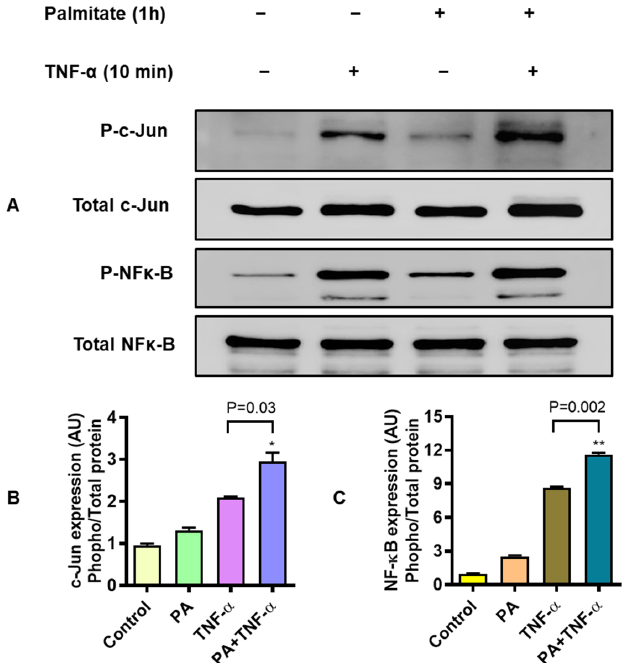
Figure 5. MIP-1 α co-induction by palmitate and TNF- α implicates signaling via c-Jun / NF- κ B. To test whether the MIP-1 α co-induction by palmitate and TNF- α involved c-Jun and NF- κ B signaling, THP-1 monocytic cells were treated with palmitate (200 µ M for 1 h) and TNF- α (10 ng / mL for 10 min) while control wells were treated with vehicle only. Cells were lysed in RIPA bu ff er and 20 µ g protein from each sample was loaded for analysis by SDS-PAGE. The representative data (mean ± SEM) from three independent determinations with similar results show the downmodulated expression of ( A ) MIP-1 α transcripts ( P = 0.01) and ( B ) MIP-1 α secretory protein ( P = 0.002) in resveratrol-treated cells as compared to controls treated with the vehicle only before co-stimulation with palmitate and TNF- α . ( A ) Western blots show the expression of hyperphosphorylated c-Jun (p-cJun) and NF- κ B (p-NF- κ B) proteins against respective total proteins in THP-1 monocytic cells co-stimulated with palmitate and TNF- α as compared to their expression in cells treated with either palmitate or TNF- α . Normalization of phosphorylated against total proteins shows significantly increased expression of ( B ) phosphorylated c-Jun and ( C ) phosphorylated NF- κ B in cells co-stimulated with palmitate and TNF- α , compared to individual stimulations with palmitate or TNF-α. * P < 0.05 and ** P < 0.01.